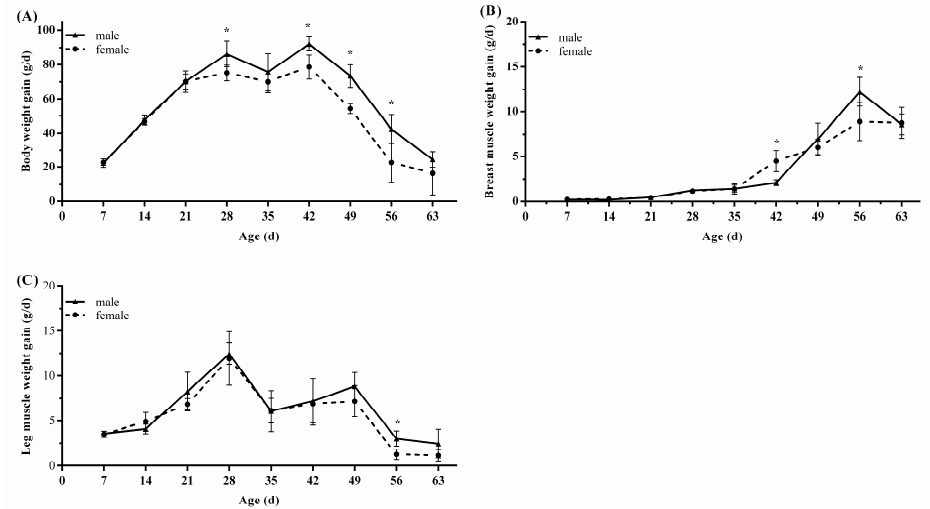
Figure 2. Absolute mass gain of body weight ( A ), breast muscle ( B ), and leg muscle ( C ) in goslings. The value for each specific day-age represents the average daily gain of the previous week. Values are given as means and standard deviation (n = 8). * represents significant difference ( p < 0.05).